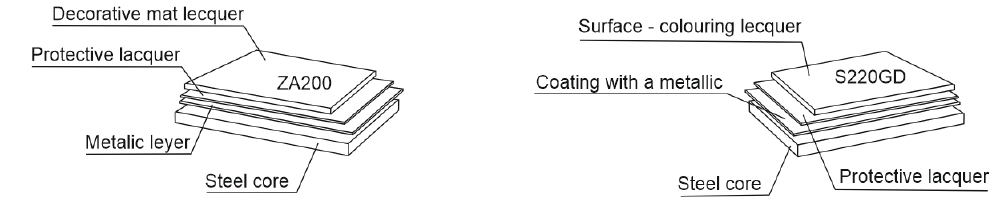
Figure 2. Schematic of applying the outer coatings on the sheet metal surfaces.